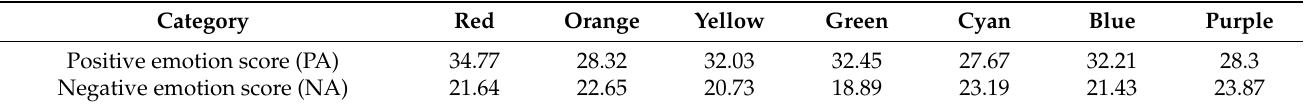
Table 1. Results of the landscape colour positive and negative emotion adjective scales. Category